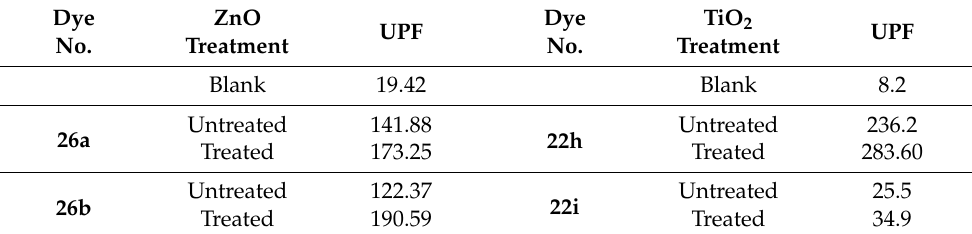
Table 6. UPF of treated polyester fabrics with ZnO or TiO 2 NPs *.